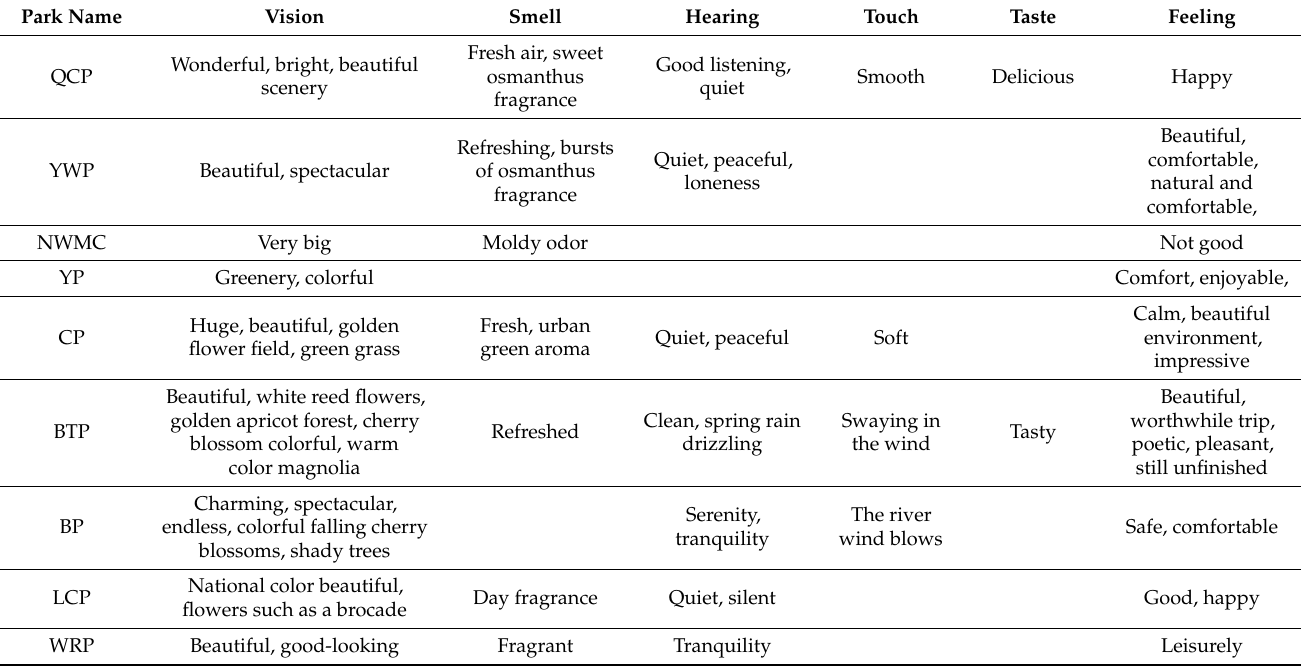
Figure 5. Scatter diagram of relative evaluation rates and relative emotion values of the landscape. Parks with relative emotional values greater than two (Qianjiang Century Park, Baita Park) had more terms related to all senses and feelings because people commented on them the most (Table 6). There were some differences in the sensory experience of parks (such as Wenyan Riverside Park, Yanjiang Park, and Yanjiang Wetland Park) with emotional values between one and two. Visitors had a good feeling about the park landscape; most perceptions were positive, such as those reflecting comfort and happiness. Among them, visual perception was stronger, and the other four senses were less evaluated, indicating that the five senses of visitors in the waterfront park were not balanced. Table 6. User sensory evaluation of the park landscape.